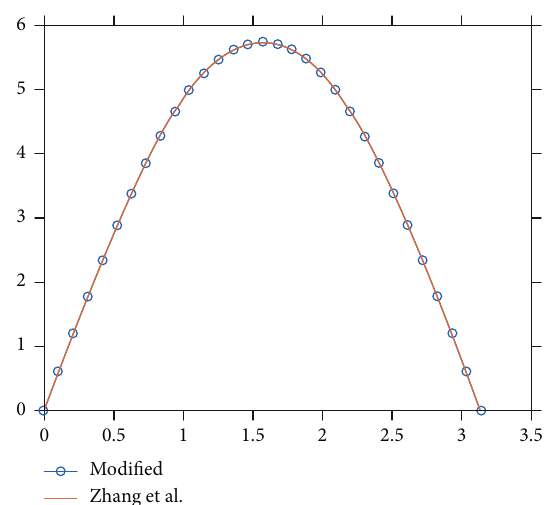
Figure 11: The variations of the system of equations (38) and the solution of the regularized system of equations (12) – (15) for p = 1 , k = 0 : 001 , α = 0 : 05 , and y = 1 .